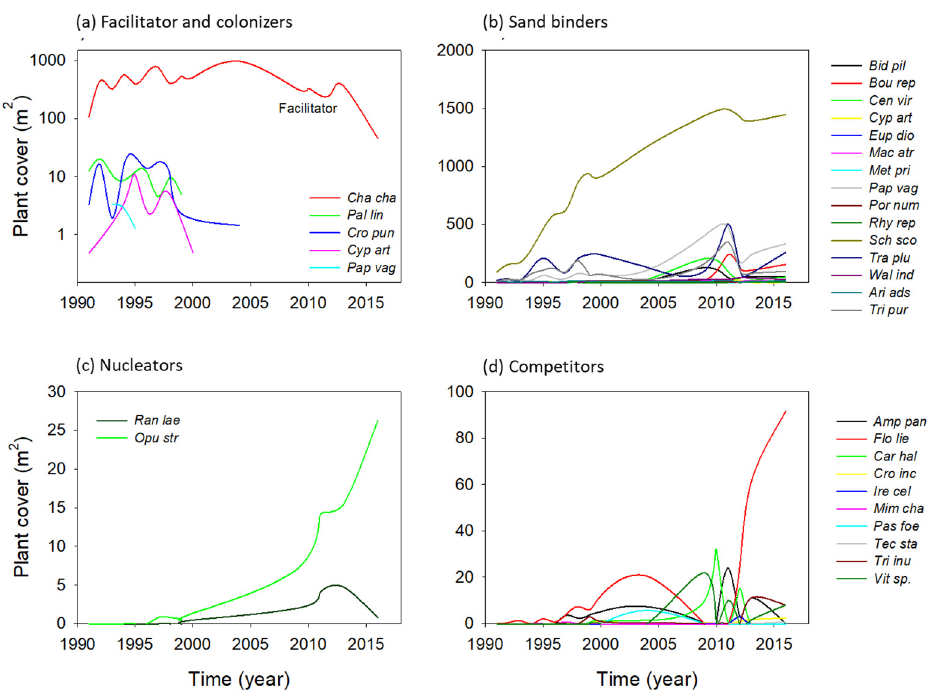
Figure 4. Species turnover during a 25 ‐ year primary succession taking place on coastal dunes in the central region of the Gulf of Mexico. Species were grouped according to four successional groups. Scale with plant cover is different for each group for clarity. Table 1 shows full species names. The lines were smoothed for clarity under the supposition that the trends during the missing years were linear. Changes in plant cover of ( a ) facilitators and colonizers ( b ) sand binders; ( c ) nucleators and ( d ) competitors from 1991 to 2016.